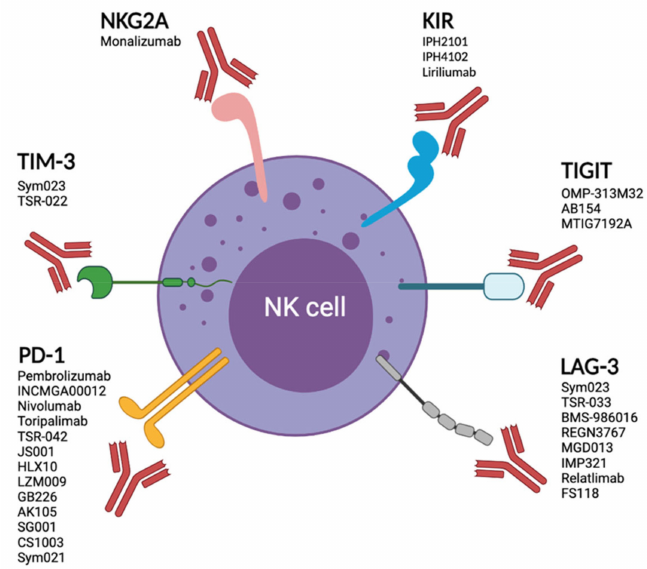
Figure 2. Enhancing NK cell functions through immune checkpoint blockade. Several immunother- apeutic approaches are currently being explored to improve NK cell effector function. Immune checkpoint blockade may result in increased NK cell numbers (in the case of anti-PD-1 therapy), increased NK cell cytotoxicity, and/or cytokine production such as IFN- γ . A vast majority of immune checkpoint therapies are delivered in combination with other agents. For example, anti-NKG2A mAb (monalizumab) has been tested as a single agent for CLL patients (NCT02557516) and in combina- tion with anti-PD-L1 (Durvalumab) for metastatic colorectal cancer (NCT02671435). KIR blockade monotherapy was used in multiple myeloma (NCT00552396, NCT00999830), or in combination with anti-PD-L1 (nivolumab) for myelodysplastic syndrome (NCT02599649), also in combination with anti PD-1 Ab (Nivolumab) and anti-CTLA-4 mAb (Ipilimumab) to treat advanced solid tu- mors (NCT03203876). Other examples include anti-TIGIT (MTIG7192A) together with